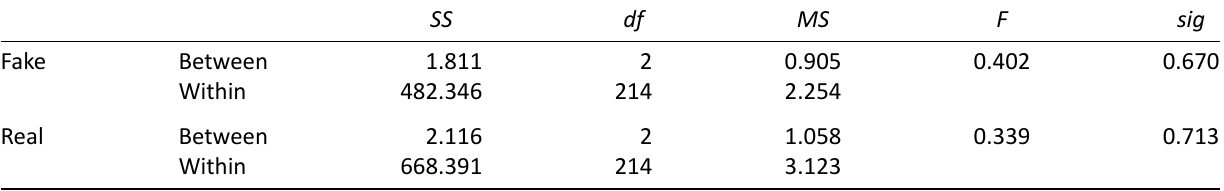
Table 10. ANOVA on the effect of interest of social and livelihood information on information judgment. SS df MS sig